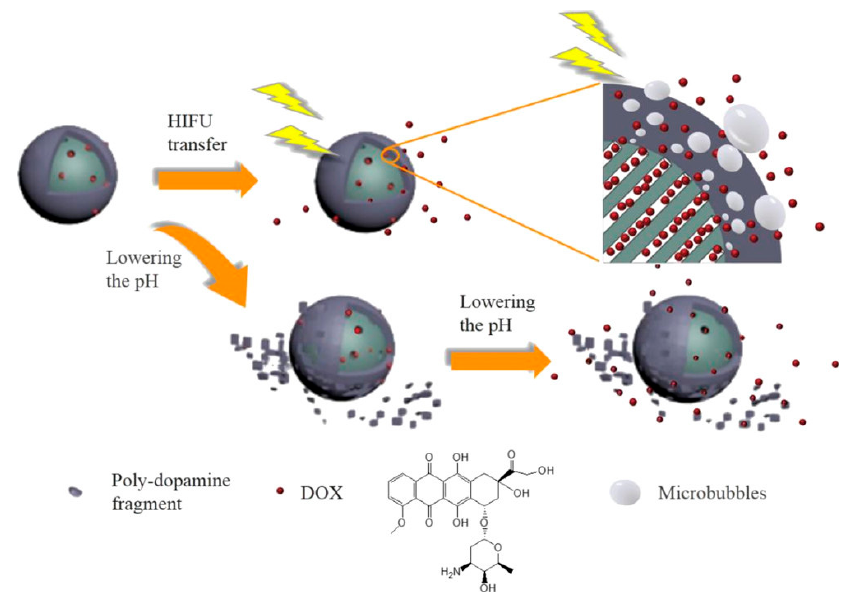
Figure 4. Pictorial presentation of pH/HIFU dual-responsive release characteristic of DOX loaded MSN–PDA. Reproduced with permission from reference [20].